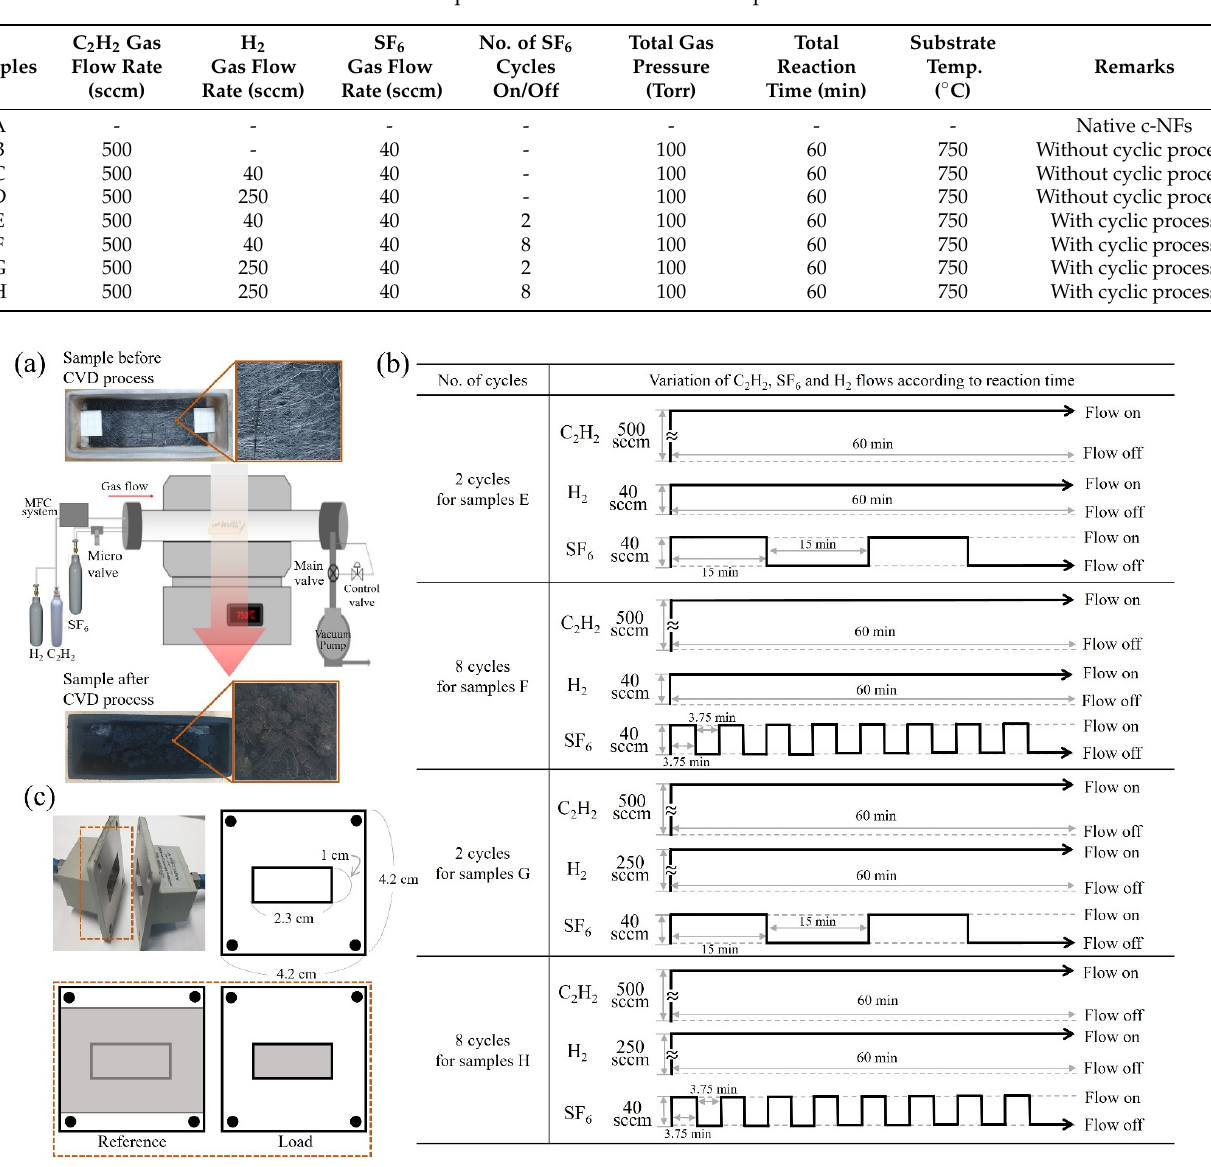
Table 1. Experimental conditions for samples A–H.